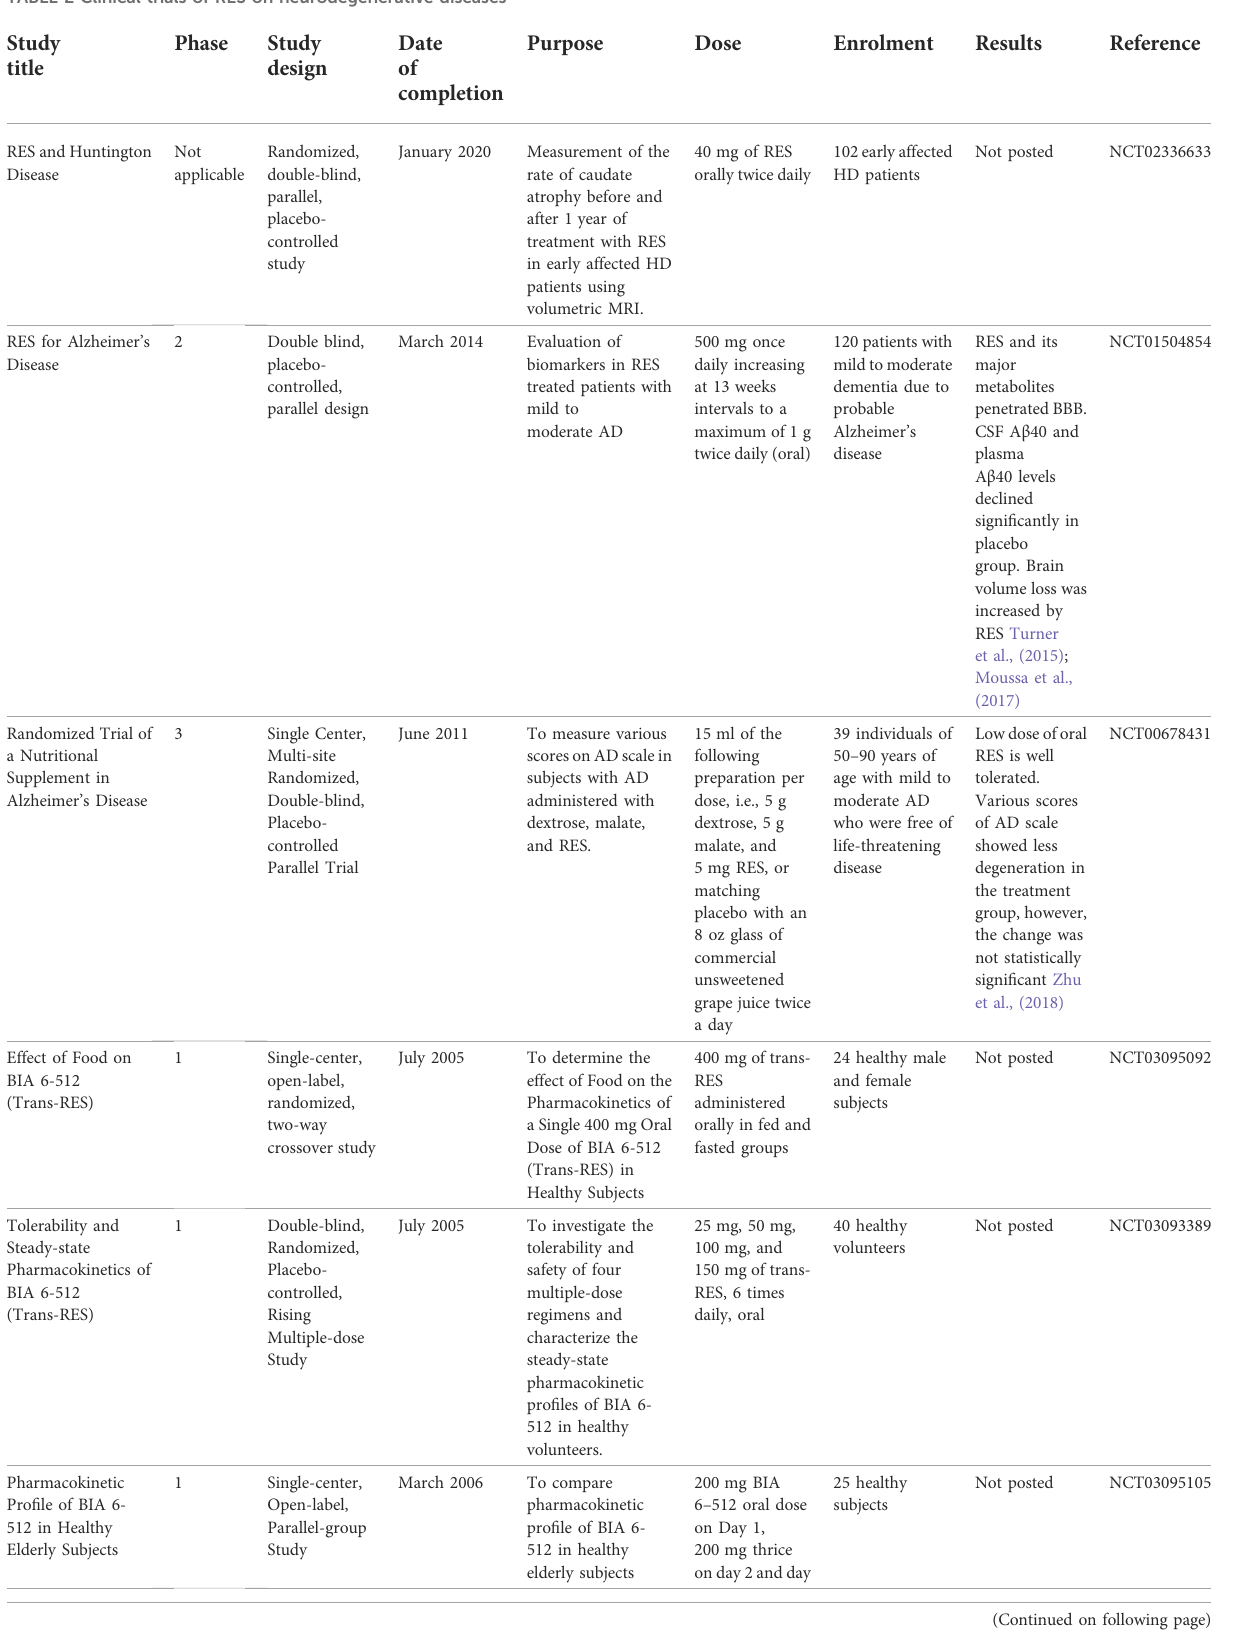
TABLE 2 Clinical trials of RES on neurodegenerative